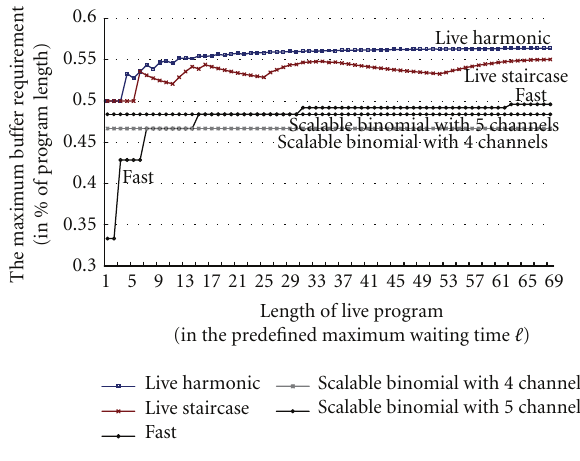
Figure 11: The maximum bu ff er requirements of each live broad- casting